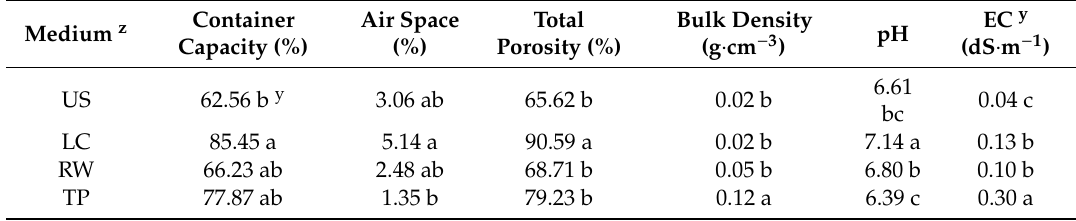
Table 1. The physicochemical properties of the growing media used in the experiment (n = 3). Medium